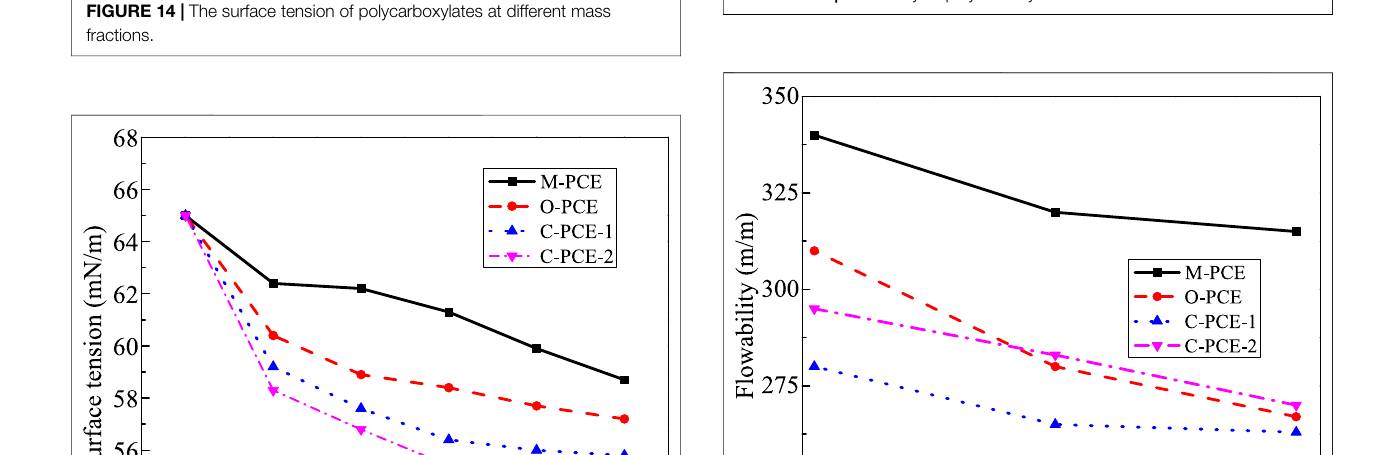
FIGURE 16 | Flowability of polycarboxylate.